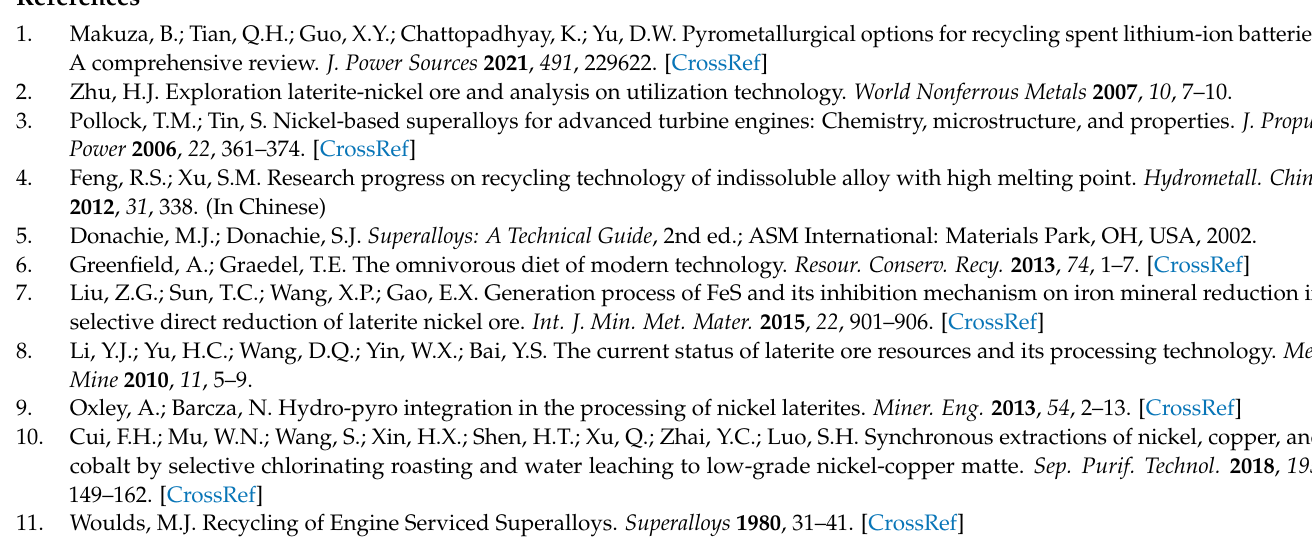
diagram, Figure S3: Mg-Zn binary phase diagram, Figure S4: Vapor pressures of selected metals as a function of reciprocal temperature, Figure S5: XRD patterns for Mg-Zn alloy of the samples under different heating temperature, Figure S6: XRD patterns for Mg-Zn alloy of the samples under different mass ratio of Mg-Zn to superalloy, Figure S7: XRD patterns for Mg-Zn alloy of the samples under different heating